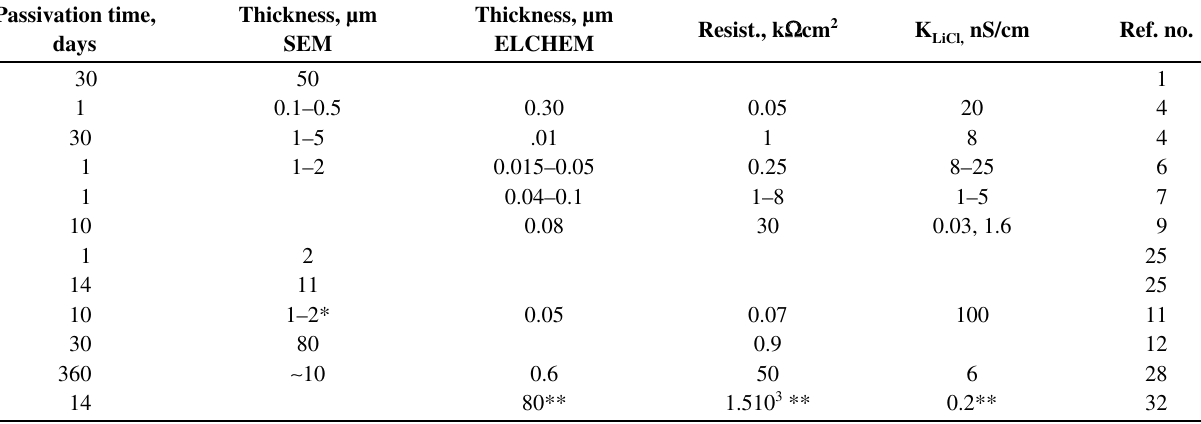
Table 2. Selected literature data describing the properties of the passivating LiCl layer on Li in SOCl re. The thicknesses obtained by electrochemical means (impedance spectroscopy or galvanostatic pulses) are compared to results from physical methods SEM, or for one group radioactive Cl-36 (marked with * ). The ELCHEM-thicknesses were calculated using the parallel plate capacitor equation. The values marked ** were measured at 25 °C on a film grown at 50 °C after removal of the SOCl Passivation time, Thickness,